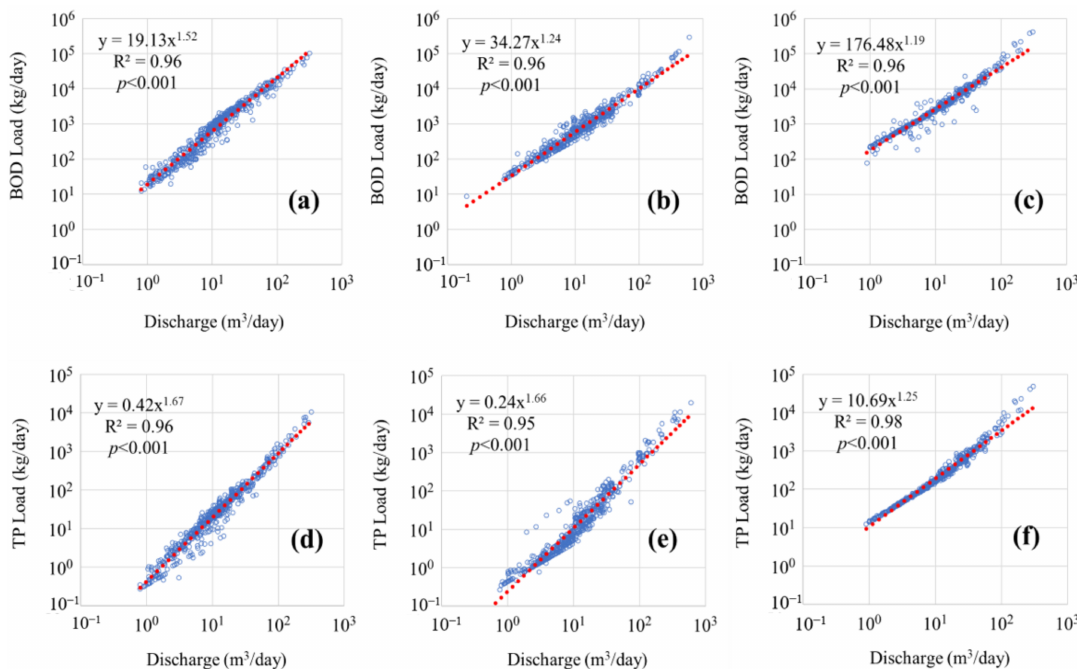
Figure 5. Relationships between the discharge and pollution loads: ( a ) BOD of JJ watershed; ( b ) BOD of HC watershed; ( c ) BOD of BH watershed; ( d ) TP of JJ watershed; ( e ) TP of HC watershed; ( f ) TP of BH